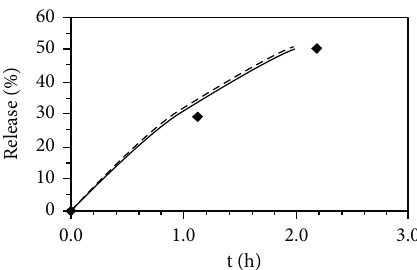
Figure 43: Release curve of the drug delivered by 1 g of microcapsules, in 80 mL of external solution, perfectly mixed, where the process of drug degradation is absent. The diamond symbols represent the experimental data, the dotted line the release predicted by the model that considers a unique class of particles characterized by average properties, and the continuous line the release predicted by the model that uses distinct classes to represent the particle size distribution